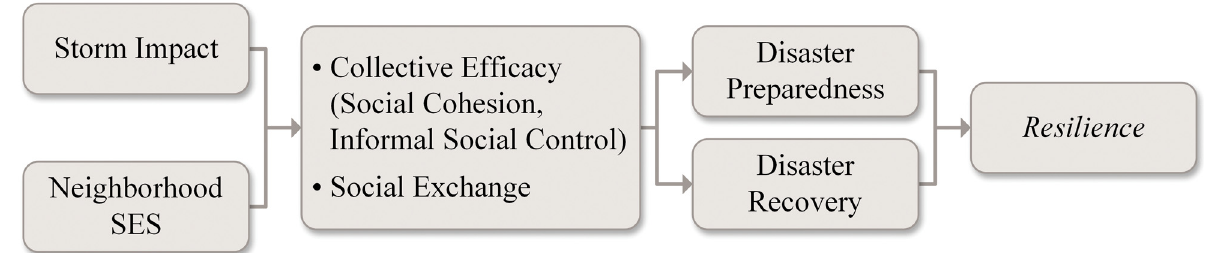
Fig 1. Conceptual model of social resources and their relationship to